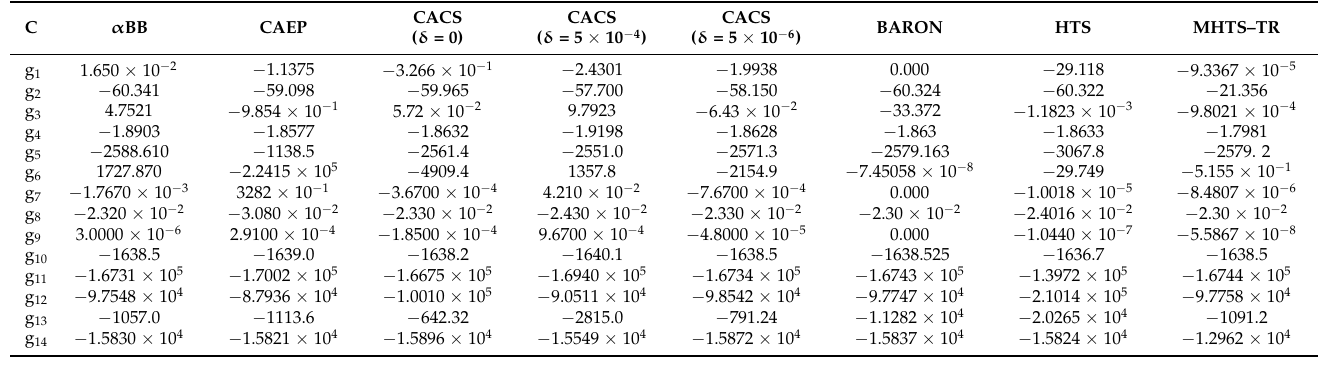
Table 8. The violations of constraints for the α BB, CAEP, CACS, BARON, HTS, and MHTS–TR methods.